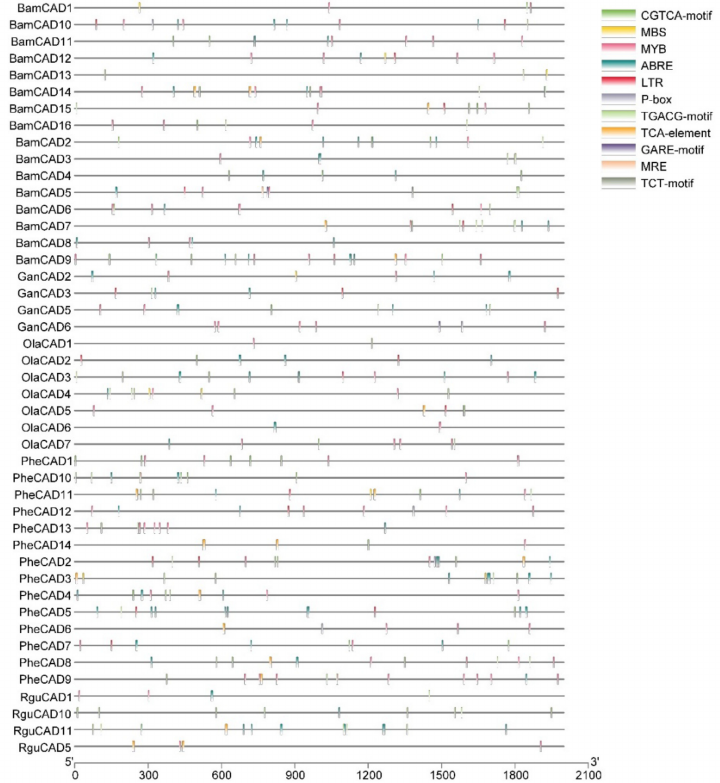
Figure 2. The conserved cis -elements analysis of CAD genes in the promoter regions of Bambu- soideae (ABRE, CGTCA-motif, GARE-motif, LTR, MBS, MRE, MYB, P-box, TCA-element, TCT-motif and